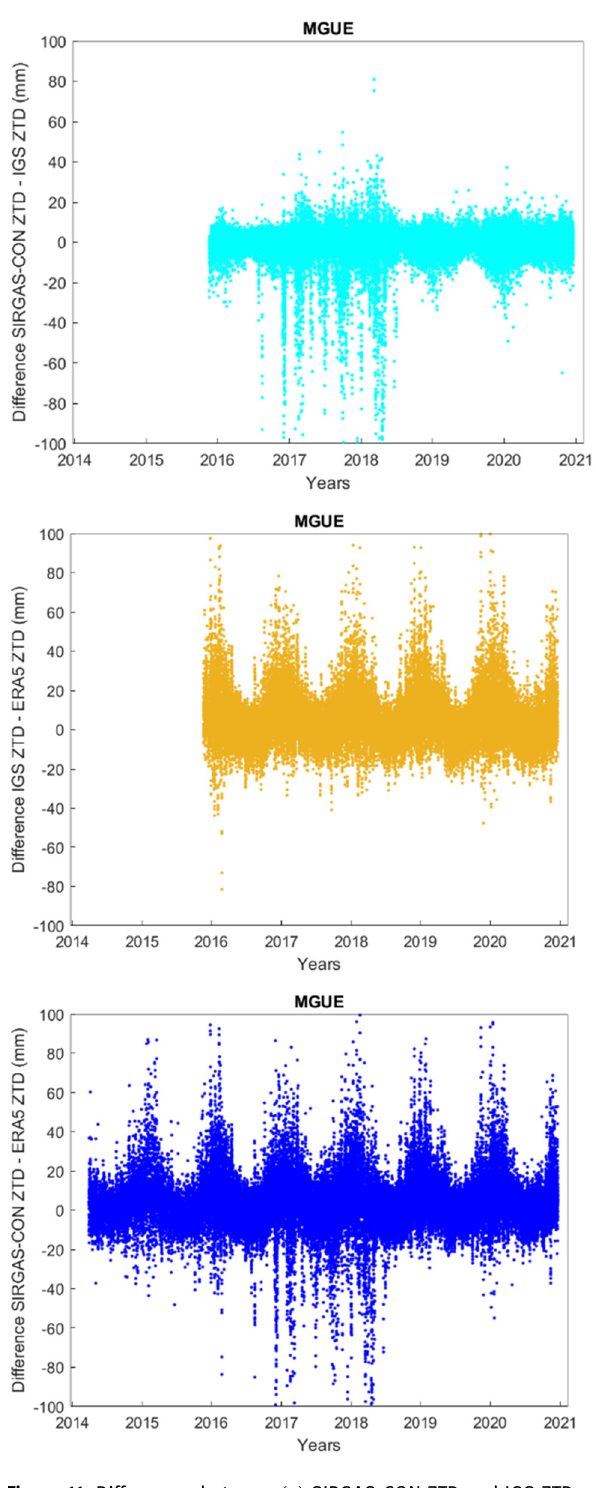
Figure 11: Di ff erences between ( a ) SIRGAS - CON ZTD and IGS ZTD; ( b ) IGS ZTD and ERA5 ZTD; and ( c ) SIRGAS - CON ZTD and ERA5 ZTD for station